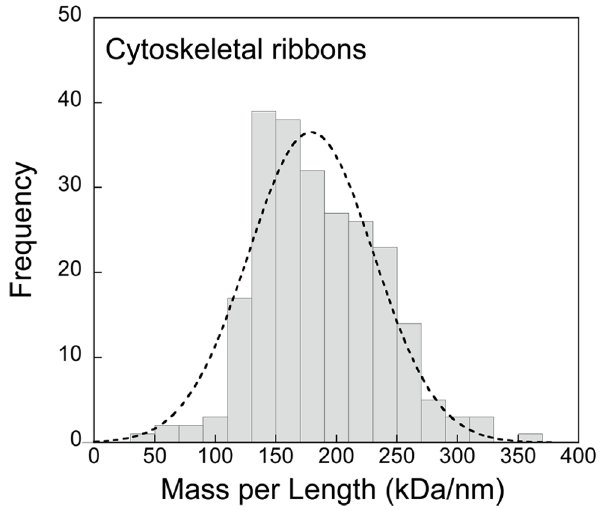
Figure 8. A histogram of the mass-per-length distribution for Spiroplasma cytoskeletal ribbons. A Gaussian fit (r 2 =0.932) is superimposed on the histogram suggesting a normal distribution. The average linear mass density is 189 6 70 kDa/nm (SD).